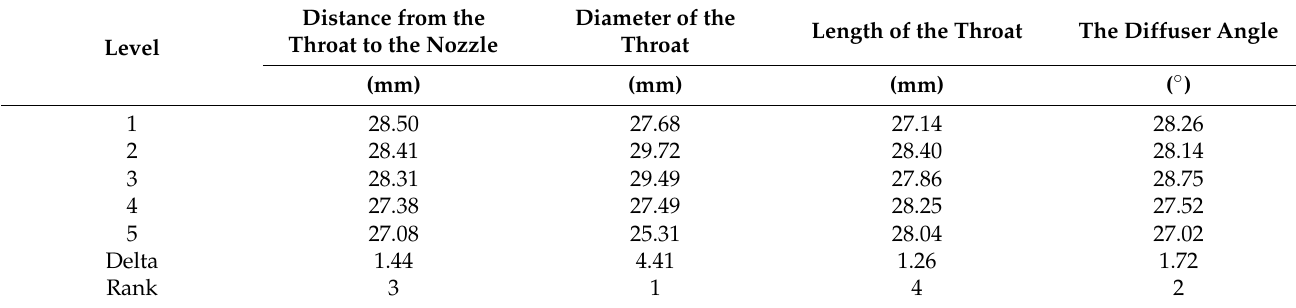
Table 12. The mean response table.